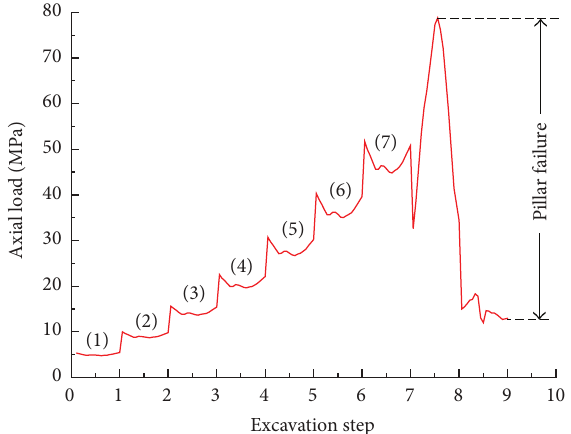
Figure 29: Pillar load history as a function of excavation step.